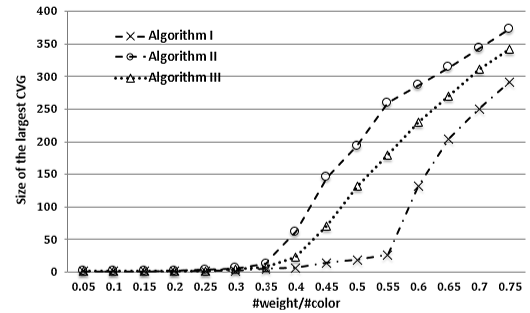
Figure 6. Survivability of different algorithms